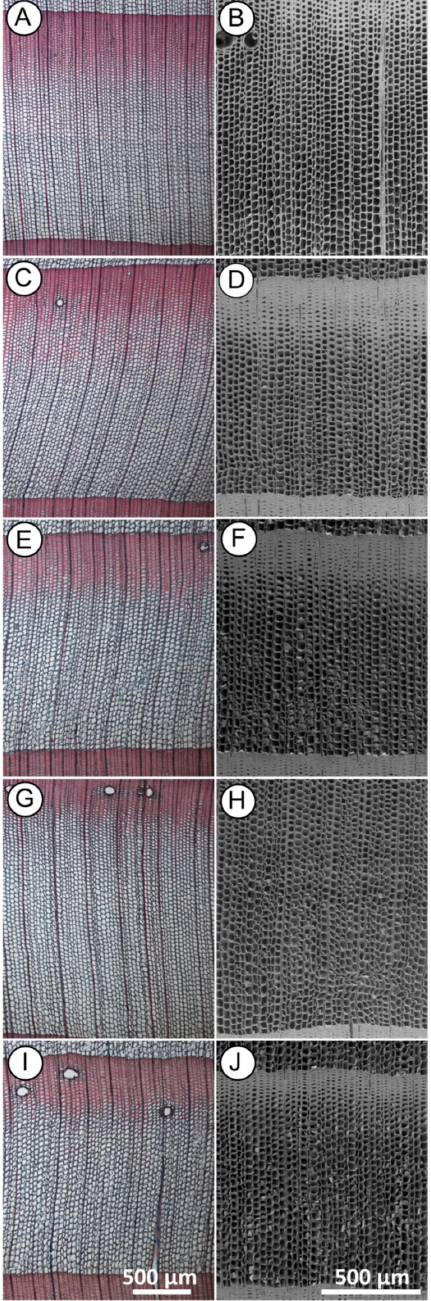
Figure 2. Cross-sections of Norway spruce observed with light microscopy ( A , C , E , G , I ) and scanning electron microscopy (SEM) ( B , D , F , H , J ) showing general changes in the tracheid cell walls structure be- tween control and after microwave (MW) treatment. (( A , B )—untreated wood; ( C , D ) heartwood and ( E , F ) sapwood)—MW treated with moderate intensity (MI); (( G , H ) heartwood and ( I , J ) sapwood)— MW treated with high intensity (HI). Scale bar = 500 µ